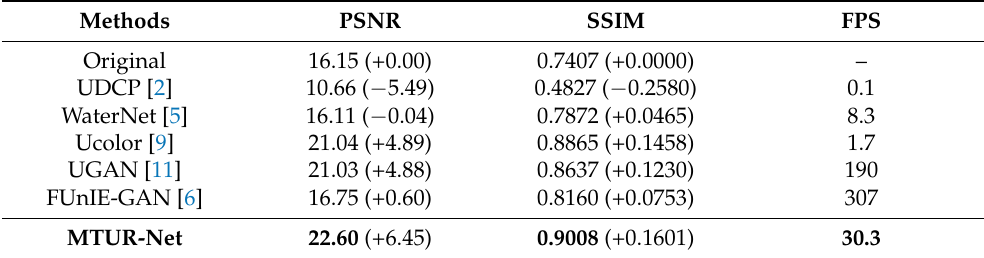
Table 1. Comparison the State-of-the-Art Methods Using the PSNR and SSIM on the Test-R90 Dataset [5].